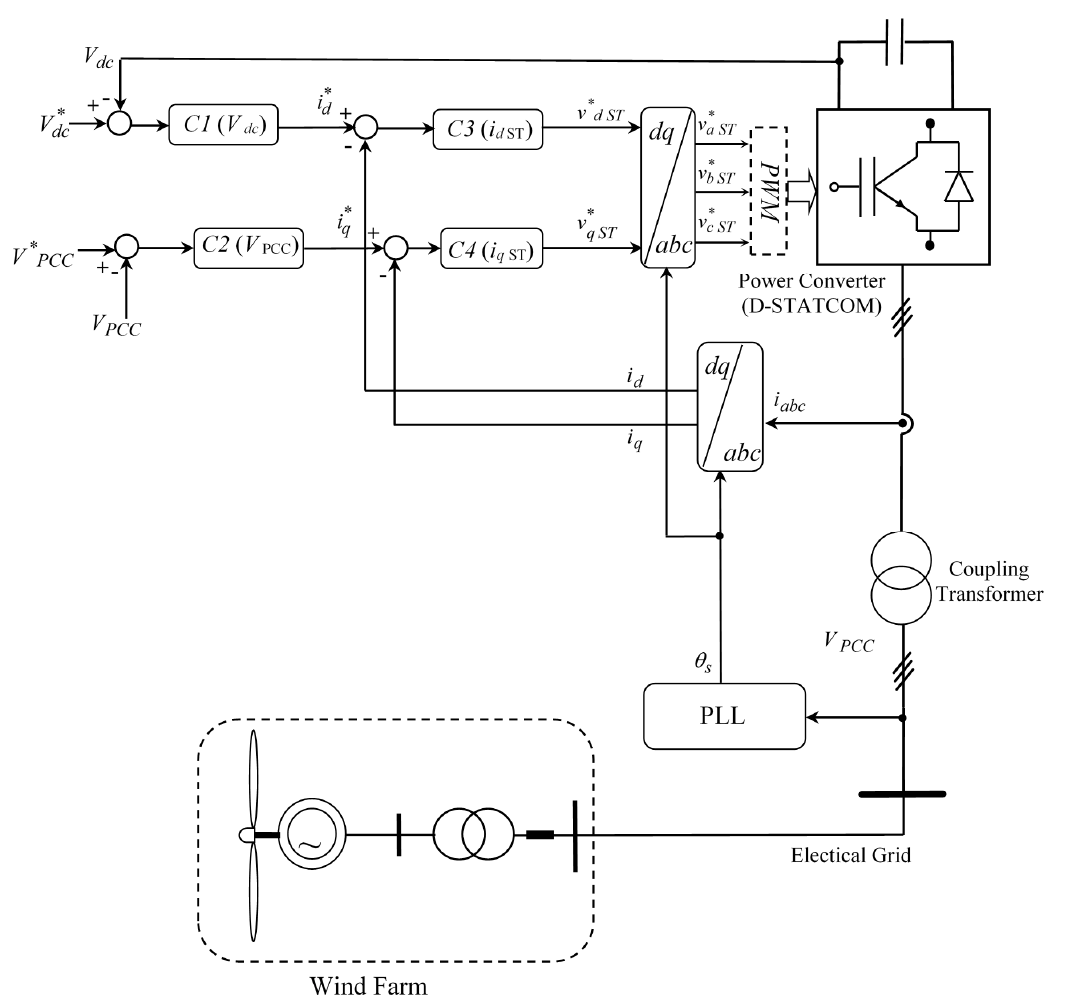
Figure 10. Control configuration of the distribution static synchronous compensator (D-STATCOM) connected to the PCC with a wind farm.